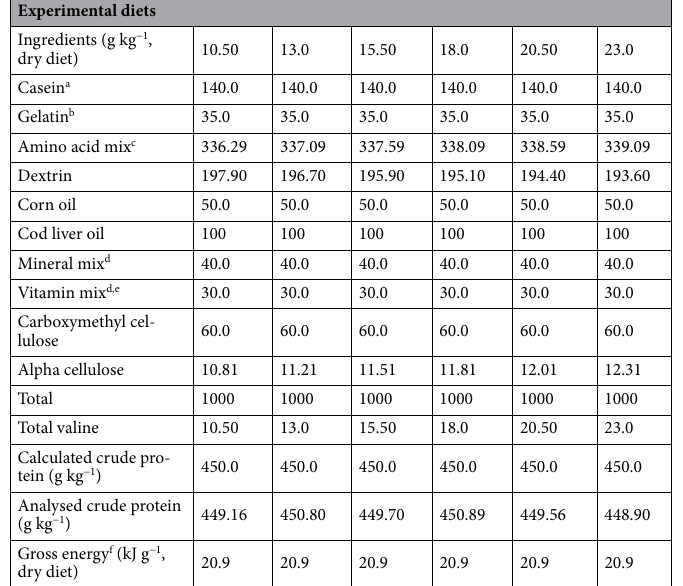
Table 5. Composition of experimental diets used for estimating the dietary valine requirement of fingerlings rainbow trout, Oncorhynchus mykiss. a Crude protein (80%), b Crude protein (93%), Loba Chemie, India; c Essential amino acids (g kg −1 ) arginine 17.71, histidine 4.48, isoleucine 23.80, leucine 22.17, lysine 15.94, methionine 11.57, phenylalanine 17.57, threonine 11.72, tryptophan 4.88, valine Variable. Non-essential amino acids cystine 9.04, tyrosine 10.83, alanine 15.30, aspartic acid variable, proline 14.34, serine variable, glycine variable (Loba Chemie, India). d Halver 2002 mineral (AlCl 3 . 6H 2 O, 150; ZnSO 4 . 7H 2 O, 3000; CuCl,100; MnSO 4 .4-6H 2 O, 800; KI,150; CoCl 2 .6H 2 O,1000 mg kg −1 ; plus USP # 2 Ca (H 2 PO 4 ) 2 . H 2 O, 135.8; C 6 H 10 CaO 6 327.0;